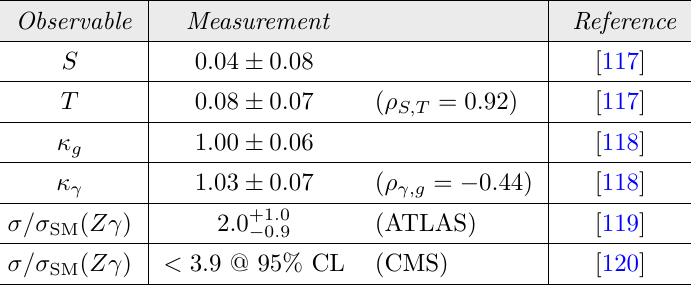
Table 5 . Bosonic observables for the LQ potential